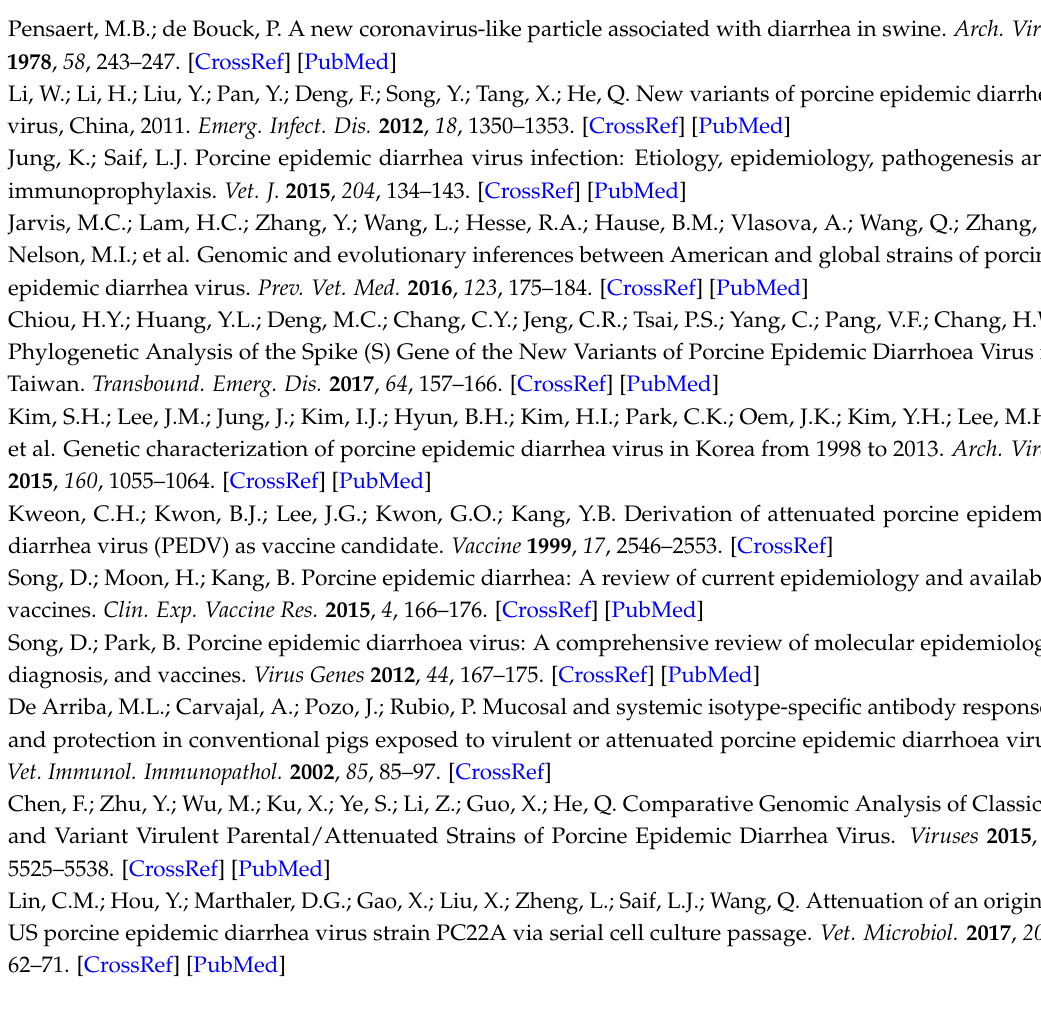
Table S1: List of sequencing